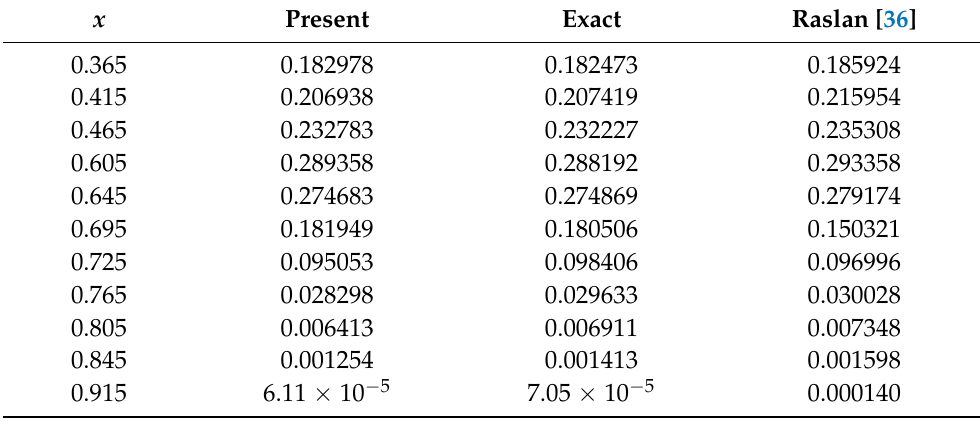
Table 4. Comparison of u ( x ,2 ) at some points x